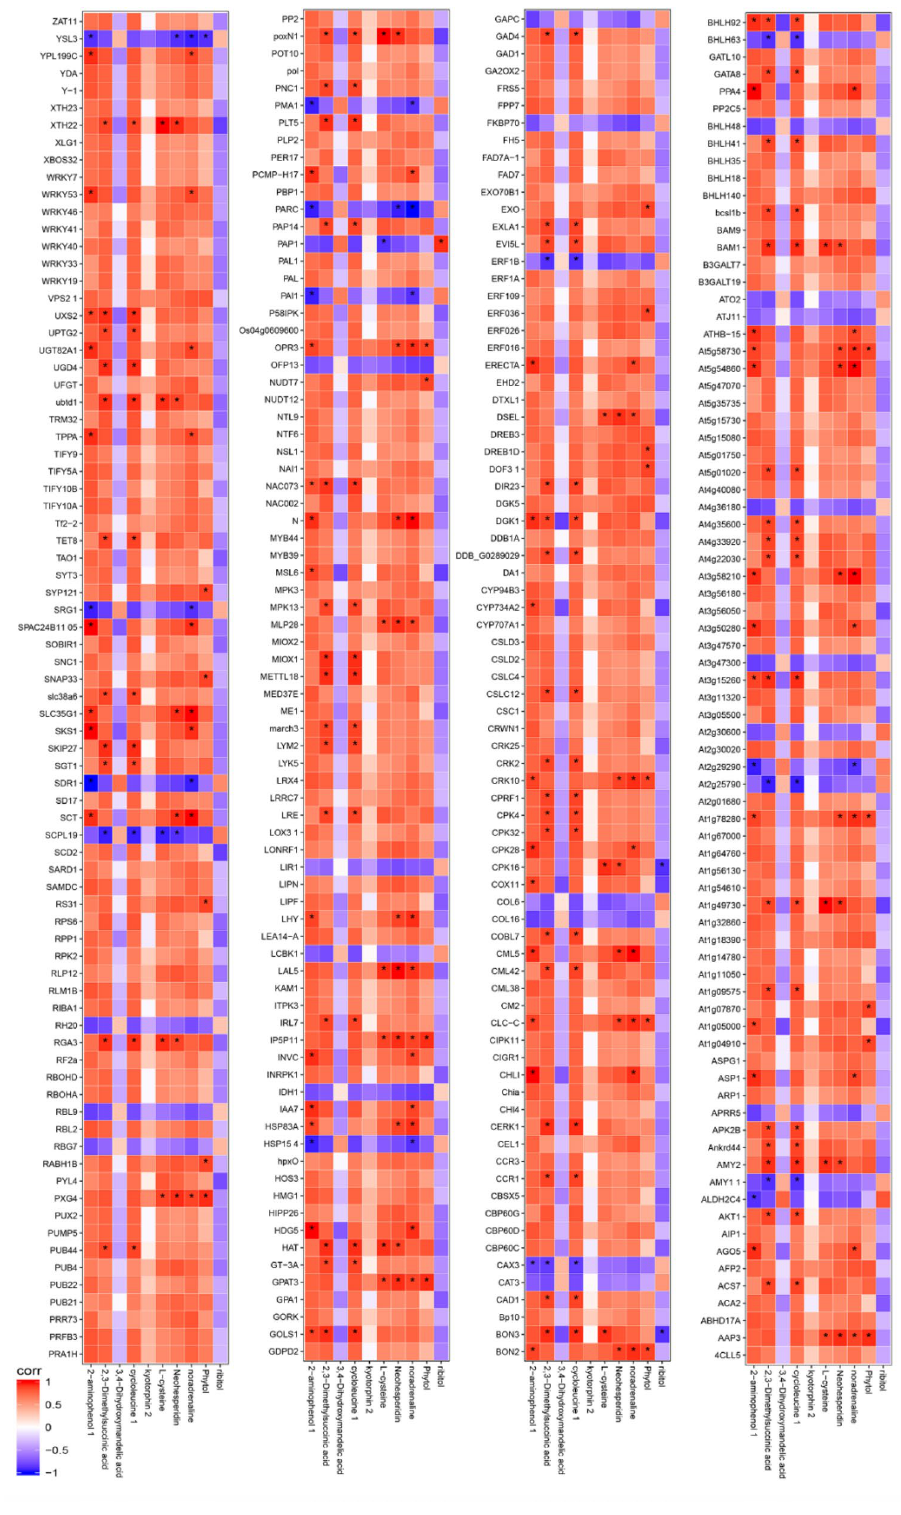
Figure 9. Heat map of correlation between differential genes and differential metabolites s in N. sibirica leaves (T100L vs T0L). *Indicates the correlation P value of differential metabolites and differential gene less than